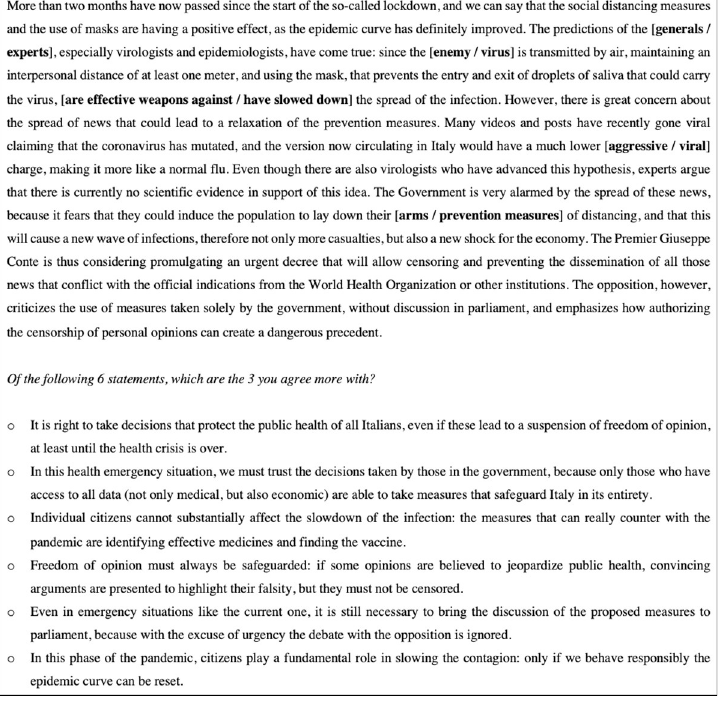
Fig 1. Transliteration in English of the scenario “Fake News” with the relative options. The metaphorical and the neutral text differed in the expressions in bold displayed within square brackets.